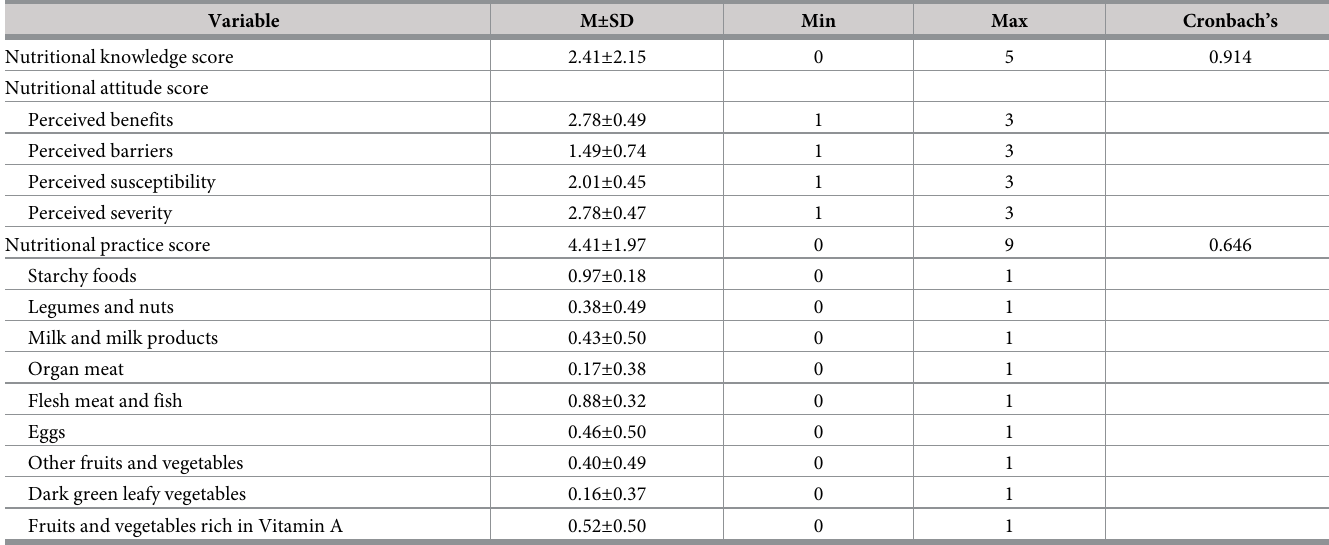
Table 2. Knowledge, attitudes and practices of nutrition (N =